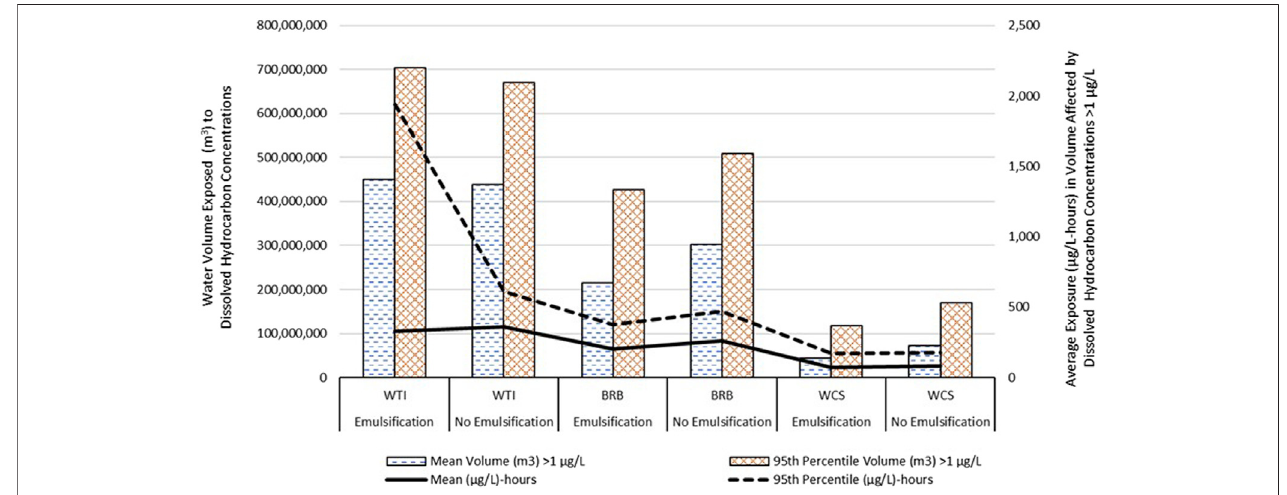
FIGURE 5 | The predicted water volume (m 3 ) exposed to dissolved hydrocarbon concentrations ≥ 1 μ g/L and the average exposure (µg/L-hours) in the volume of water affected by dissolved hydrocarbon concentrations ≥ 1 μ g/L for each oil type, with and without emulsi fi